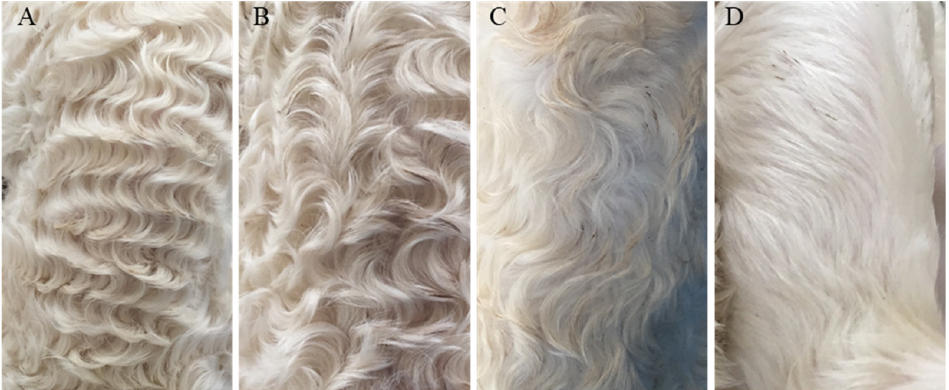
Figure 1. Different lambskin pattern types of Hu sheep. Note: ( A ): Extremely curved. ( B ): Medium curved. ( C ): Little curved. ( D ): Straight.